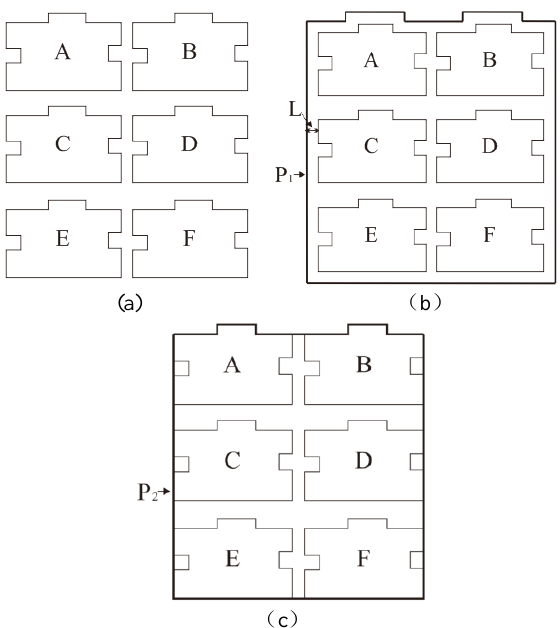
Figure 6. Dilation and erosion transformations. (a) Original pattern; (b) dilation transformation; (c) erosion transformation.